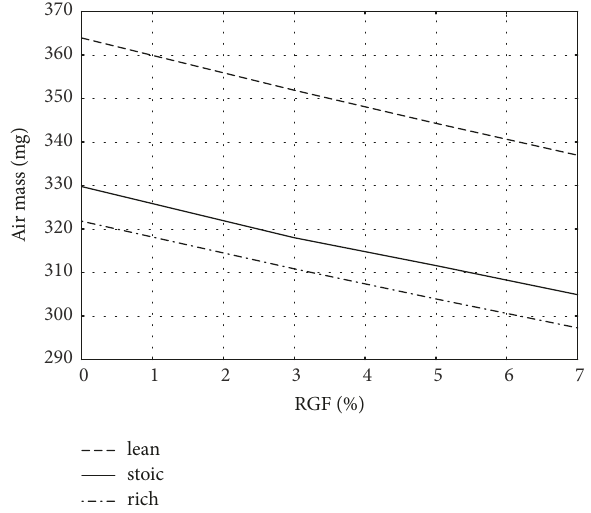
Figure 4: Variation of initial cylinder air mass with